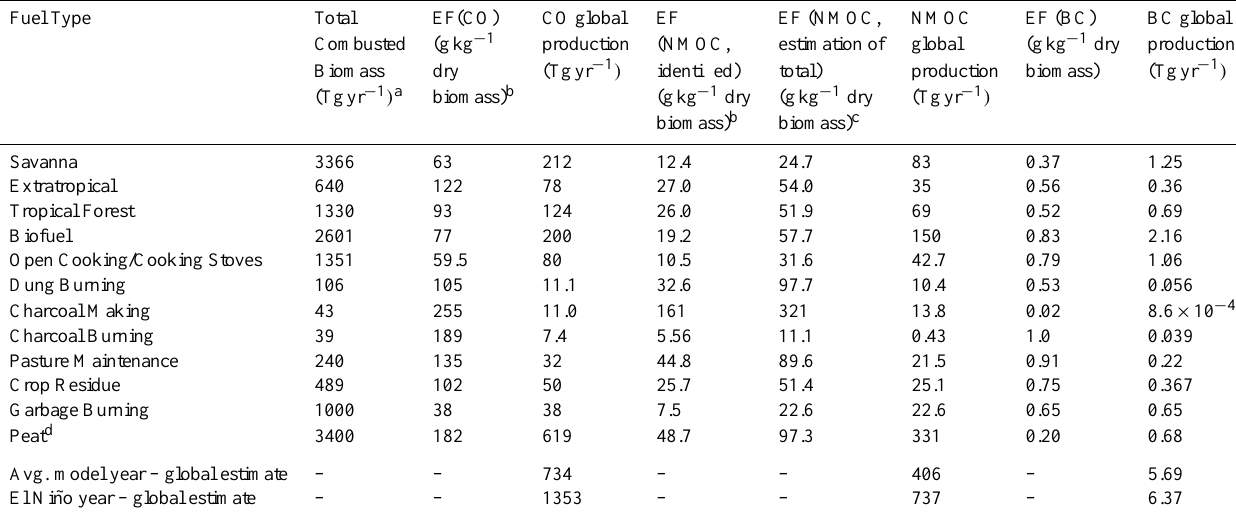
Table 5. Measured and predicted estimates of NMOC emitted from biomass burning on an annual